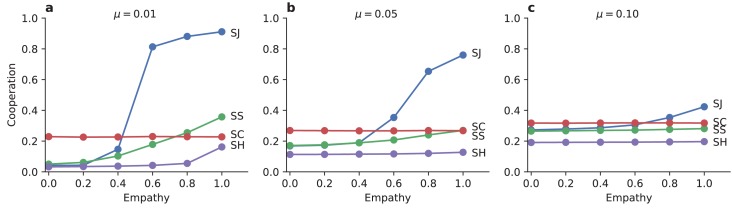
Mean cooperation rates with continuous strategies.The figure shows results of Monte Carlo simulations assuming a continuous strategy space (p,q)∈[0,1]2, with mutations sampled uniformly. The qualitative results agree with those reported in Figure 3 for discrete strategies: Stern Judging (SJ) produces the highest rates of cooperation when empathy is high, but it performs poorly under non-empathetic moral evaluation. b/c=5, e1=e2=0.02, N=100.